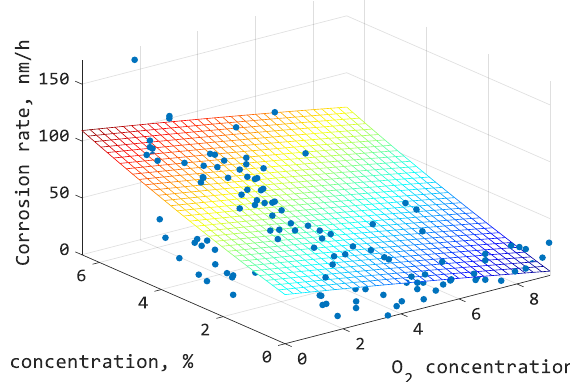
Figure 15. Correlation between O 2 and CO concentration and the corrosion rate of the evaporator tubes, determined based on ultrasonic measurements.